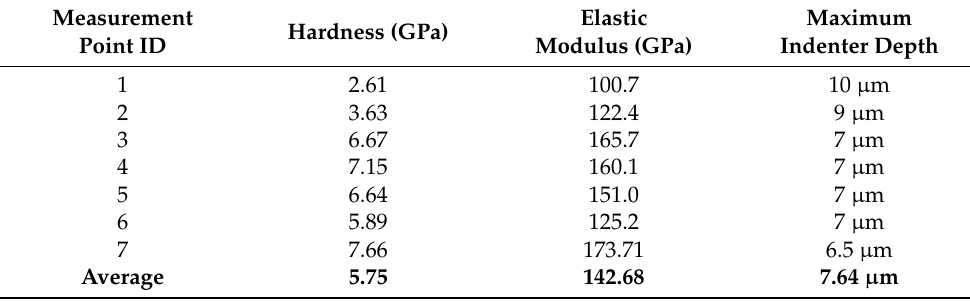
Table 4. Monolithic Ni-P Coating Vickers Hardness Measurement.